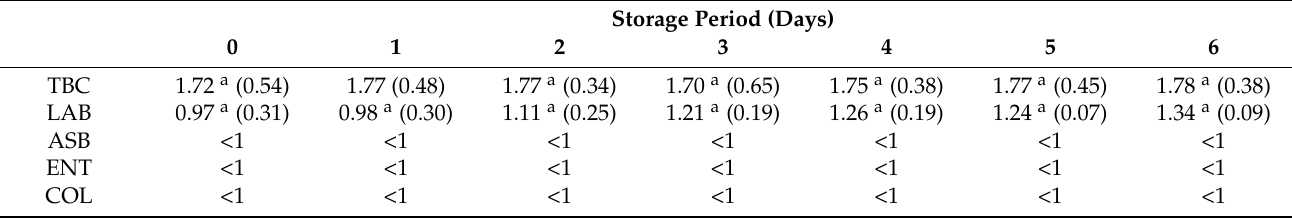
Table 1. Microbial quality of donkeys’ milk during storage at 4 ◦ C. Storage Period (Days)